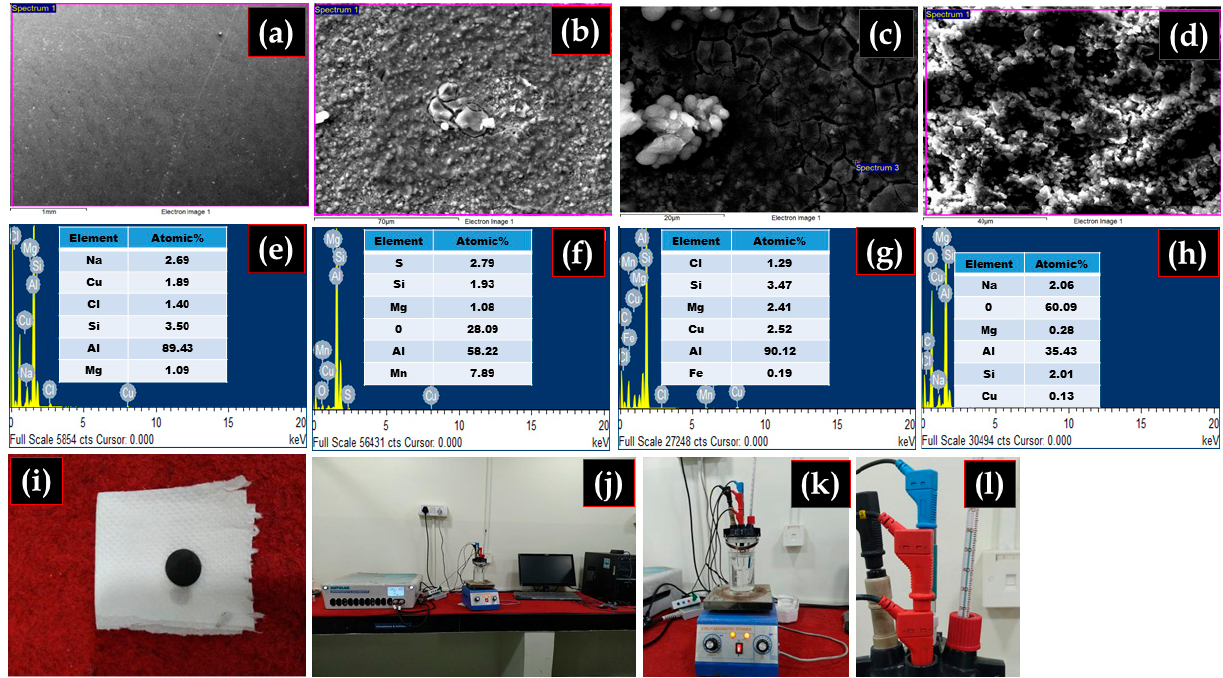
Figure 8 . SEM morphology of AMCs after corrosion test ( a ) NaCl ( b ) H 2 SO 4 ( c ) HCl and ( d ) NaOH, ( e – h ) EDS analysis of respective AMCs sample after corrosion, and ( i – l ) As fabricated sample and experimental setup for corrosion